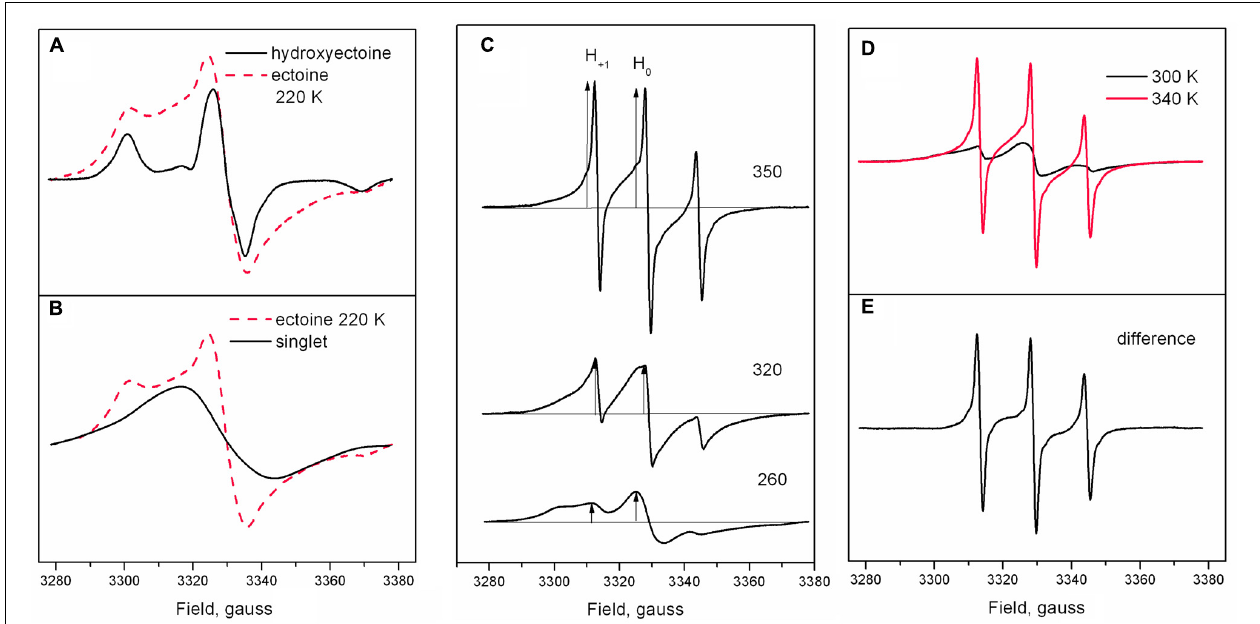
FIGURE 9 | (A) Tempone spectra from dry ectoine and hydroxyectoine at 220 K adjusted for spectral intensity and peak position; (B) a singlet obtained by subtraction of Tempone spectrum in hydroxyectoine from Tempone spectrum in ectoine as in (A) ; dashed red line is a Tempone spectrum in ectoine. (C) Tempone spectra in